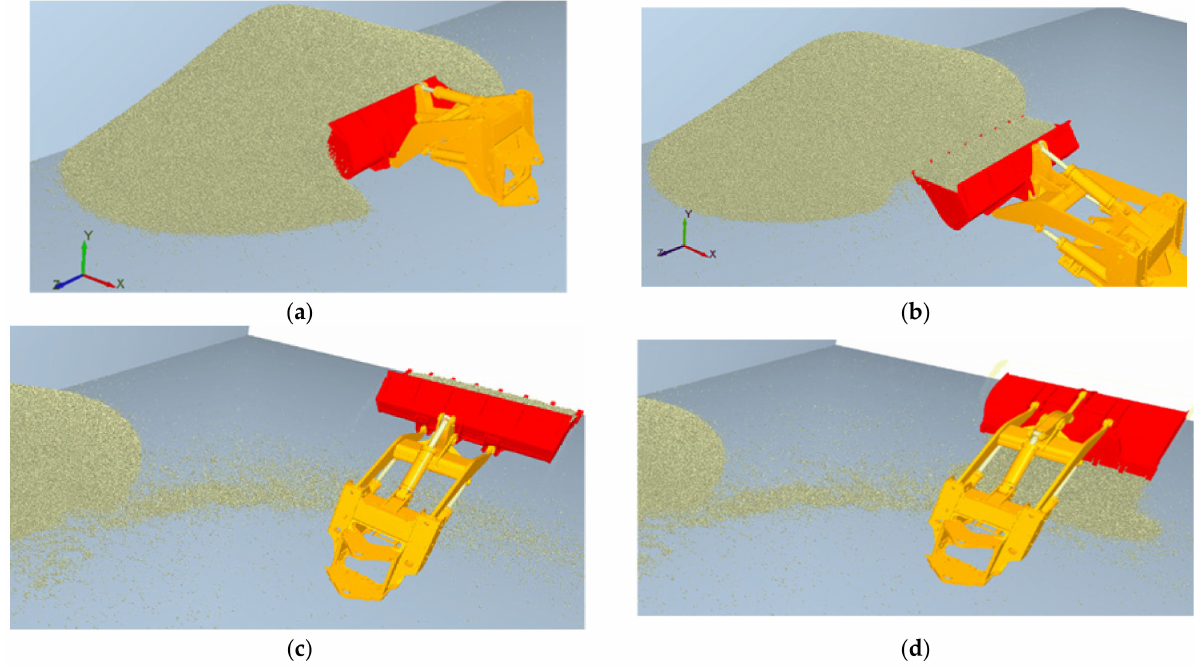
Figure 5. Co-simulation process with RecurDyn–EDEM: ( a ) insertion phase, ( b ) full load transport, ( c ) lifting stage, ( d ) unloading